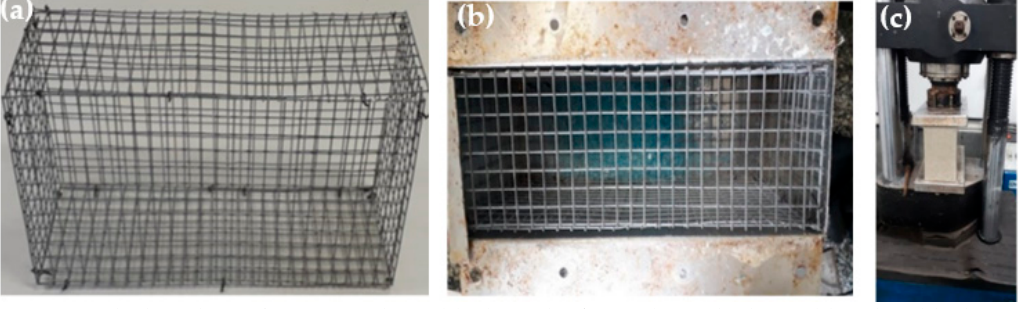
Figure 8. Block with reinforcing mesh: ( a ) block mesh; ( b ) mesh inside the mold and ( c ) block with the mesh in the test.